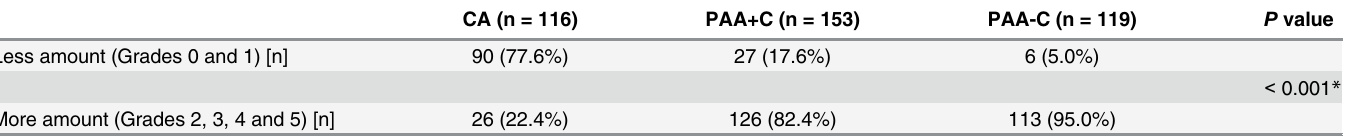
Less amount (Grades 0 and 1)